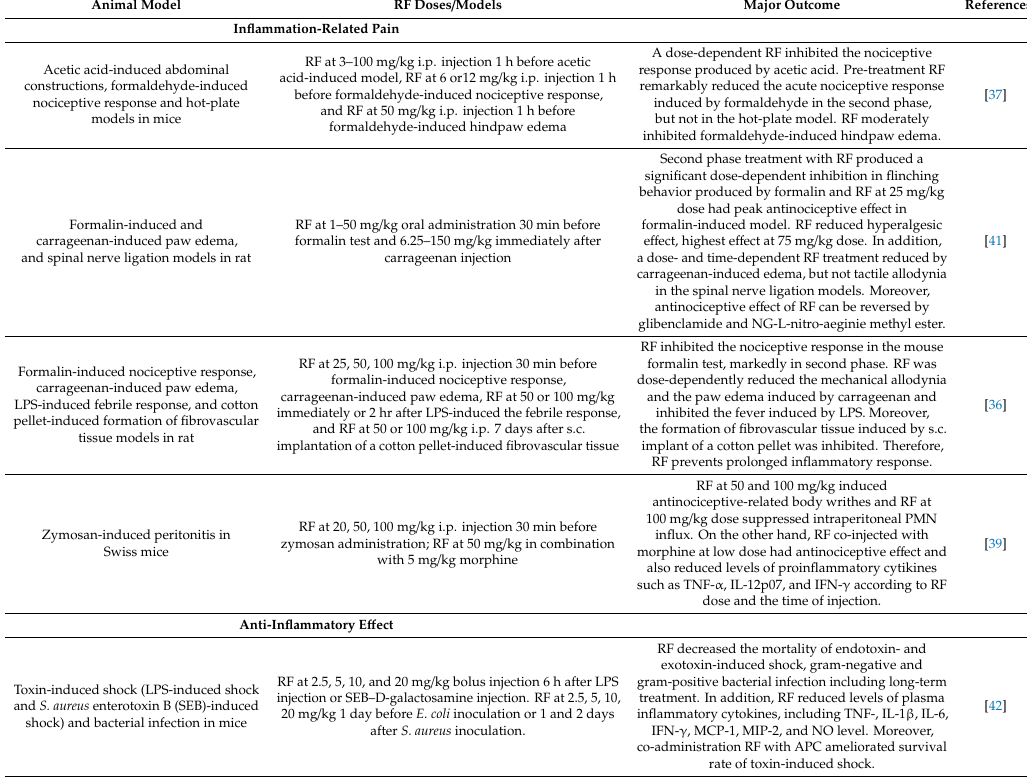
Table 4. Antinociception and anti-inflammation e ff ects of RF in animal model. AnimalModel RFDoses / Models MajorOutcome References